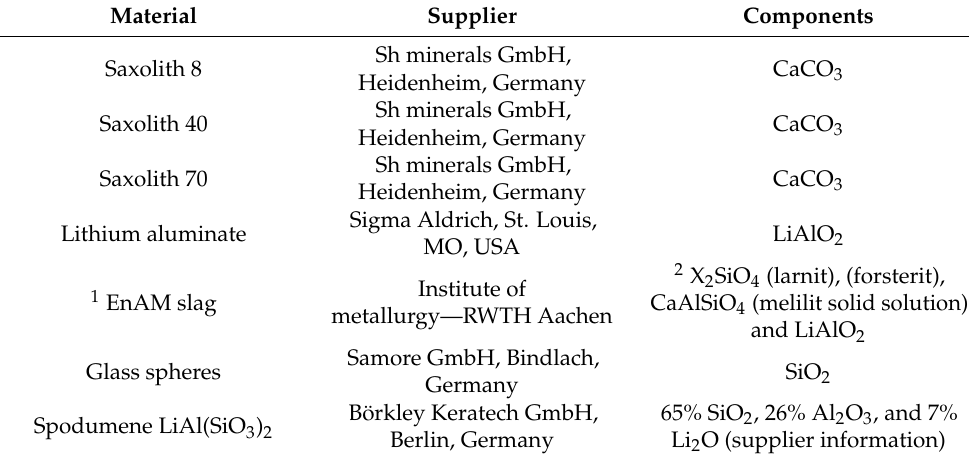
Table 1. Properties of the used